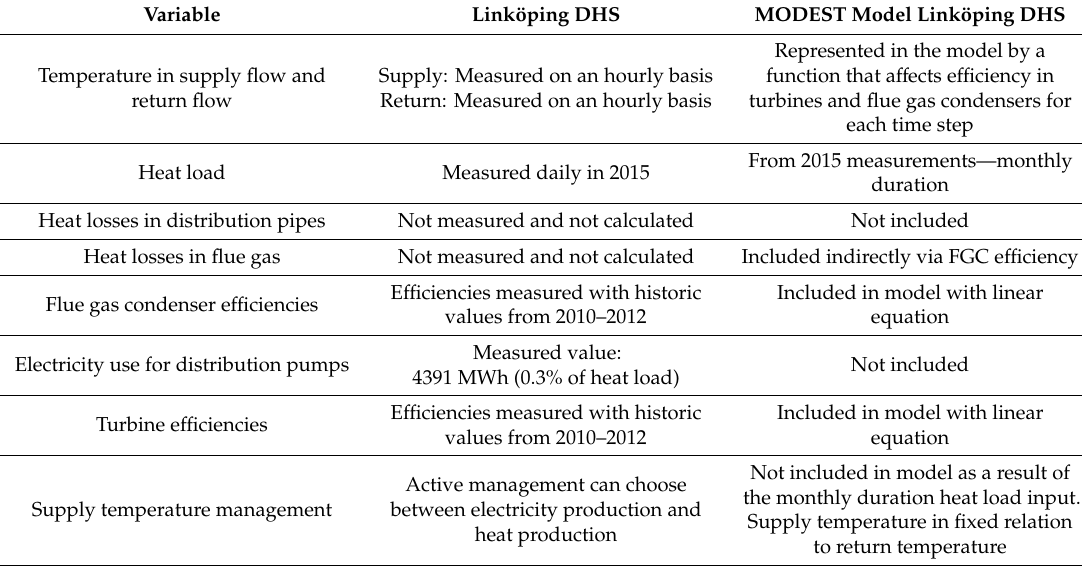
Table 2. Details of the Model for Optimization of Dynamic Energy Systems with Time-dependent components and boundary conditions (MODEST) model. DHS—district heating system.